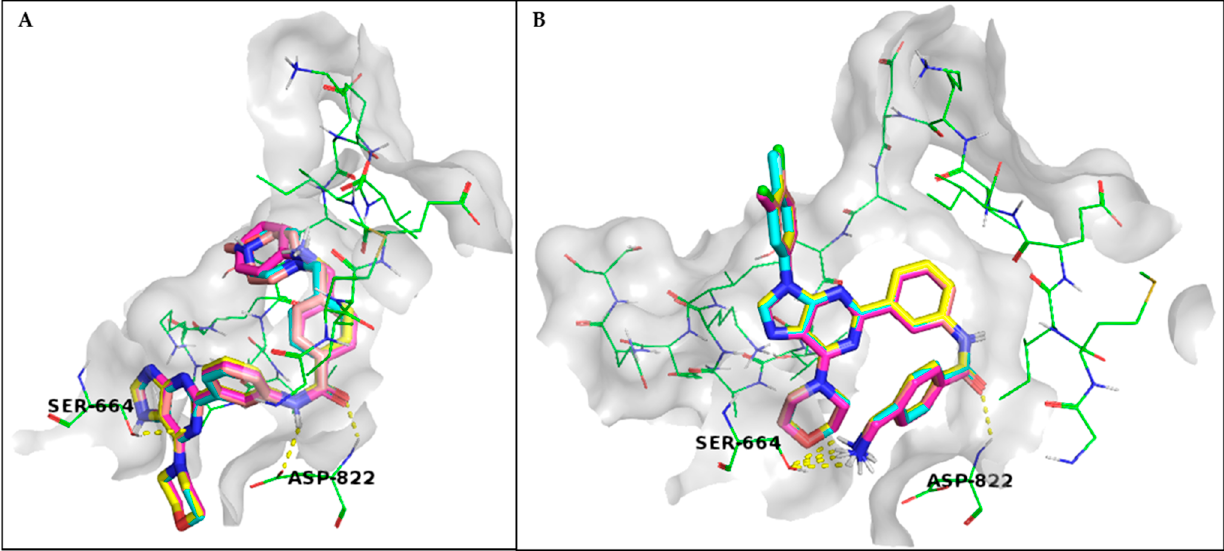
Figure 10. Interaction-binding mode of docked ligands in the active site of PI3K γ . Overlay of the selective ligands 1a , 1b , 1c , and 1d ( A ); ligands 5a , 7a , 8a , 9a , 10a , and 11a ( B ).